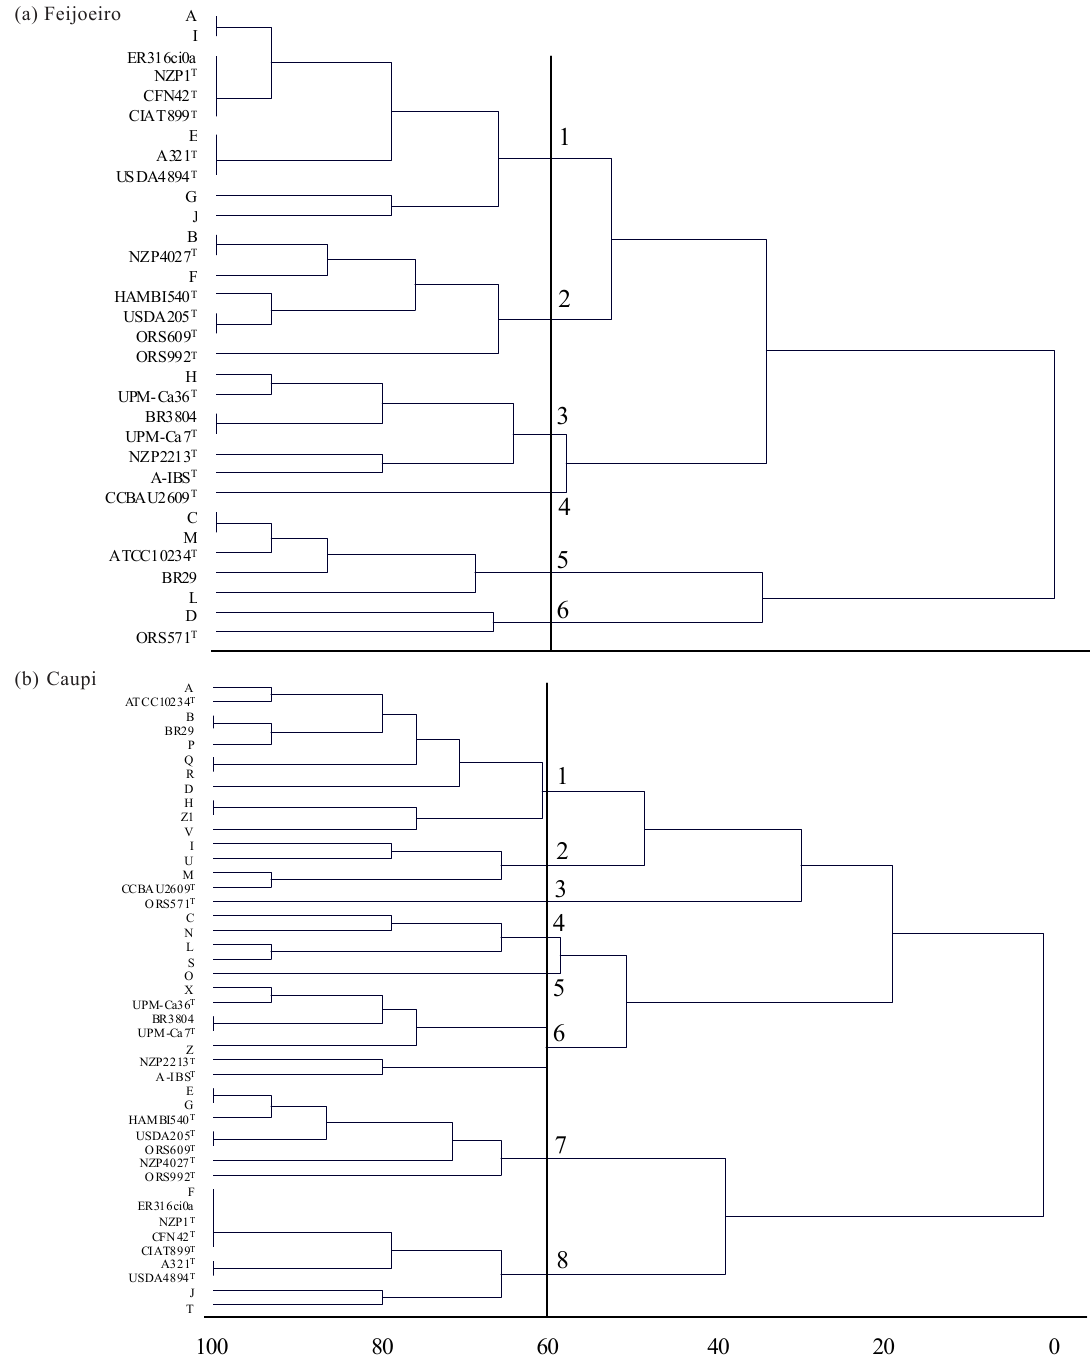
Figura 1. Dendrogramas de similaridade, construídos de acordo com os grupos fenotípicos culturais: a - grupos fenotípicos de A, B, C,... M, para os isolados de bactérias nodulíferas de feijoeiro e b - (A, B, C,... Z, Z1) de isolados de bactérias nodulíferas de caupi, ambos cultivados em amostras de solos de áreas de mineração, e com as estirpes-tipo e referência: ER 316 ci0a ( Rhizobium leguminosarum bv. phaseoli ), NZP 1 ( R. leguminosarum trifolii ), CFN 42 T ( R. etli ), CIAT 899 T ( R. tropici ), HAMBI 540 T ( R. galegae bv. orientalis ), NZP 4027 T ( Sinorhizobium meliloti ), USDA 205 T ( S. fredii cv. fredii ), A321 T ( S. medicae ), ORS609 T ( S. saheli ), USDA 4894 T ( S. terangae ), NZP 2213 T ( Mesorhizobium loti ), BR 3804 ( M. plurifarium ), UPM-Ca7 T ( M. ciceri ), CCBAU 2609 T ( M. huakuii ), A-IBS T ( M. tianshinense ), UPM-Ca36 T ( M. mediterraneum ), ATCC10324 T ( Bradyrhizobium japonicum ), BR29 ( B. elkanii ), ORS 571 T ( Azorhizobium caulinodans ), ORS 992 T ( Allorhizobium undicola ). Descrição dos grupos fenotípicos culturais nos quadros 5 e